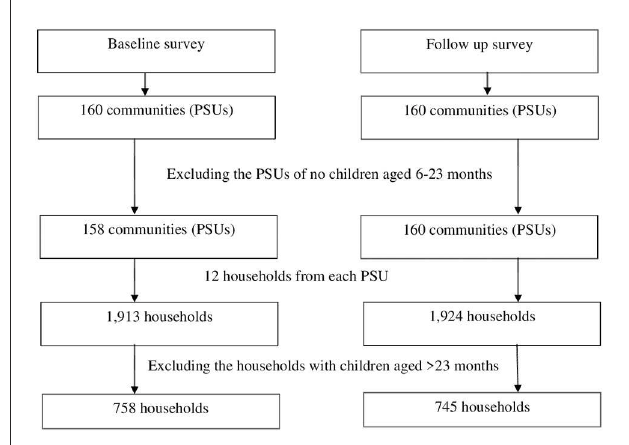
FIGURE1 Selection of the households with children aged 6–23 months.